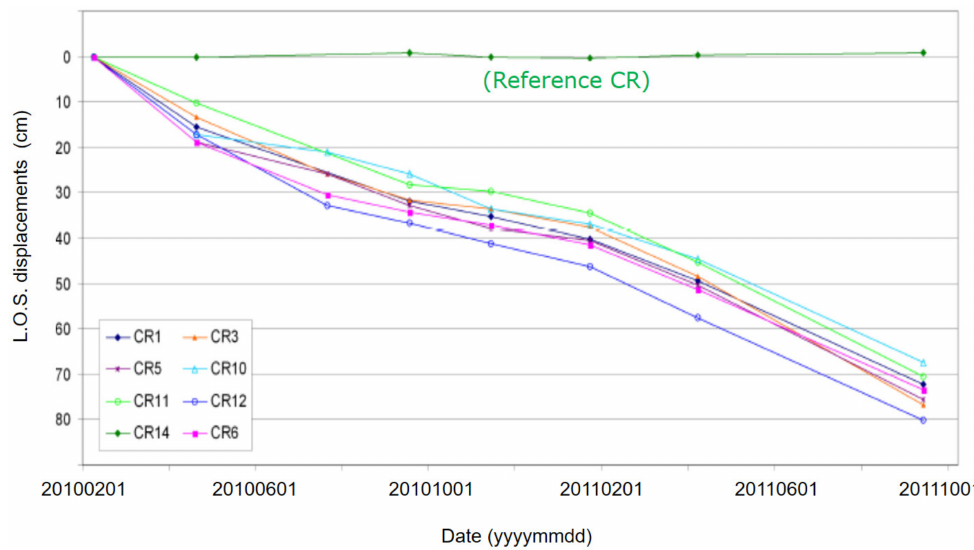
Figure 20. L.O.S. displacements measured with noninterferometric GBSAR between February 2010 and September 2011 at eight small CRs. The CR14, in a stable zone, acts as reference CR.